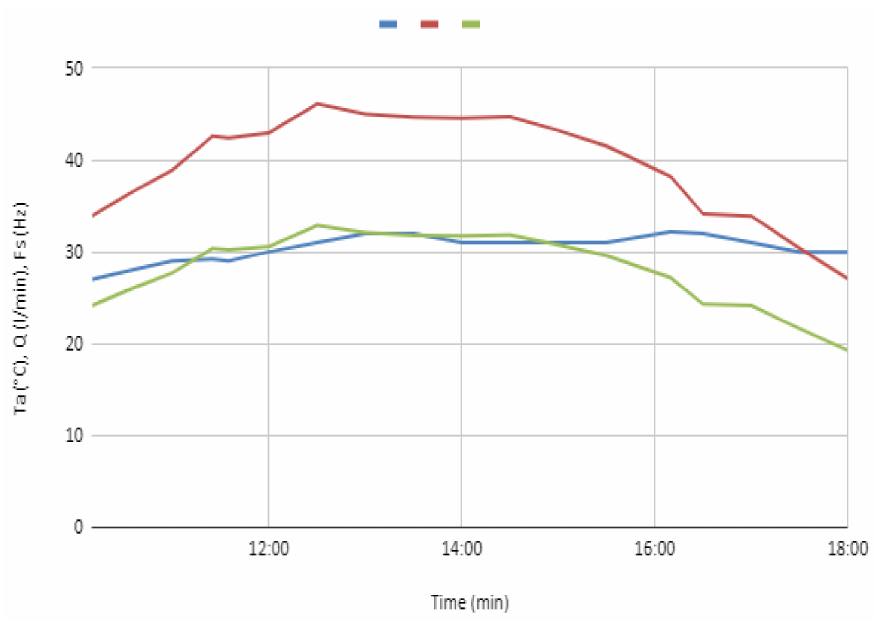
Figure 14. Rate of daily temperature variation in ( ◦ C), flow rate variation (L/min), and frequency